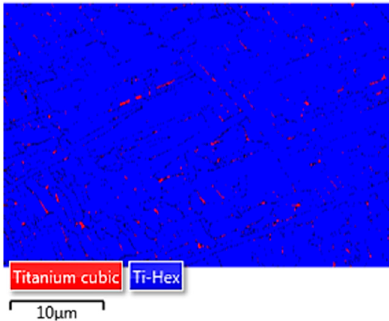
Figure 3. Phase-indexing image of Sample 4 after heat treatment taken by electron backscatter diffraction (EBSD). Regions with hexagonal close-packed (HCP) Kikuchi diffraction pattern identified as α phase and represented in blue; those with body-centered cubic (BCC) pattern identified as β phase and represented in red.